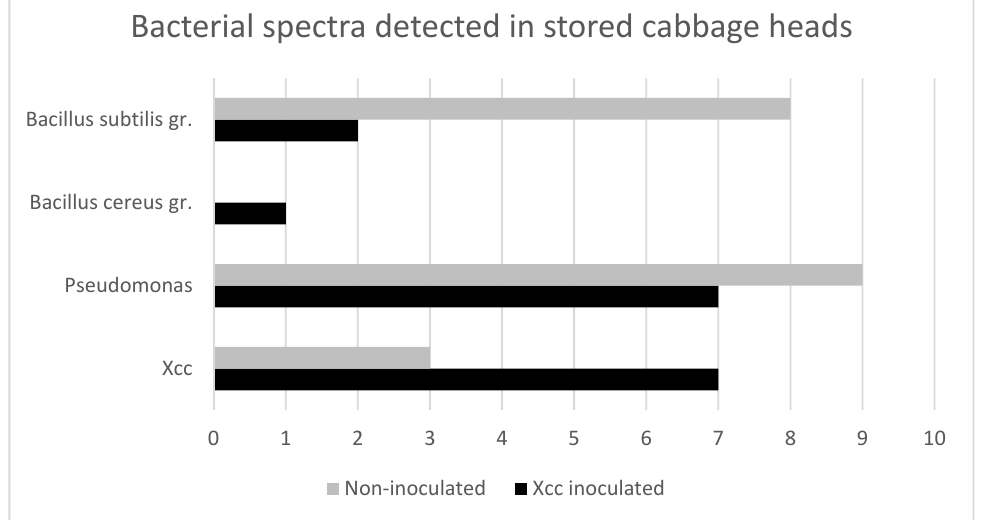
Figure 3. The number of cabbage heads from the sampling after storage of Xcc-inoculated and non-inoculated cabbage heads with positive detection of the bacterial genera.